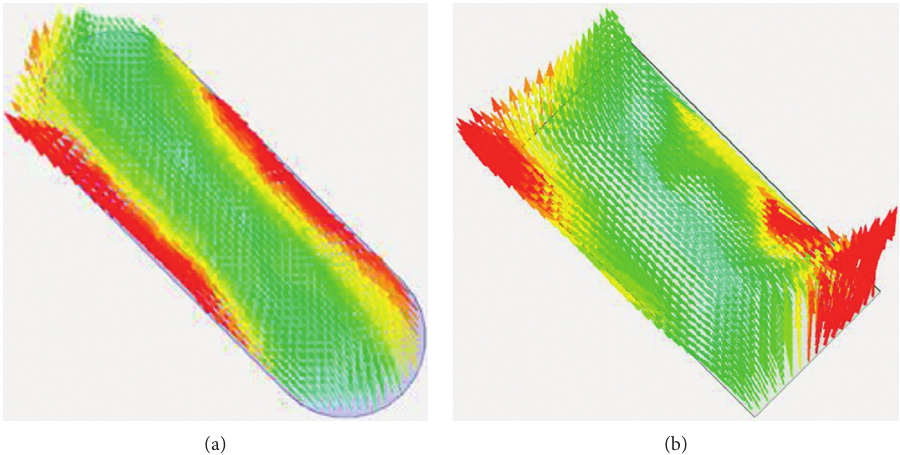
Figure 2: Surface current distribution of PCM unit. (a) Capsule. (b)